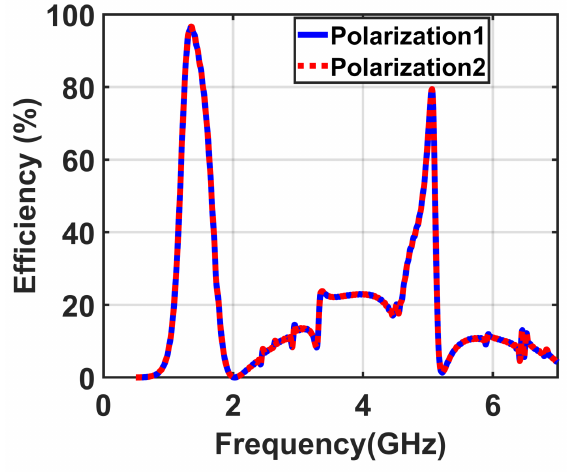
Figure 10. Obtained results illustrating the efficiency of the implemented supercell for both TE and TM modes.